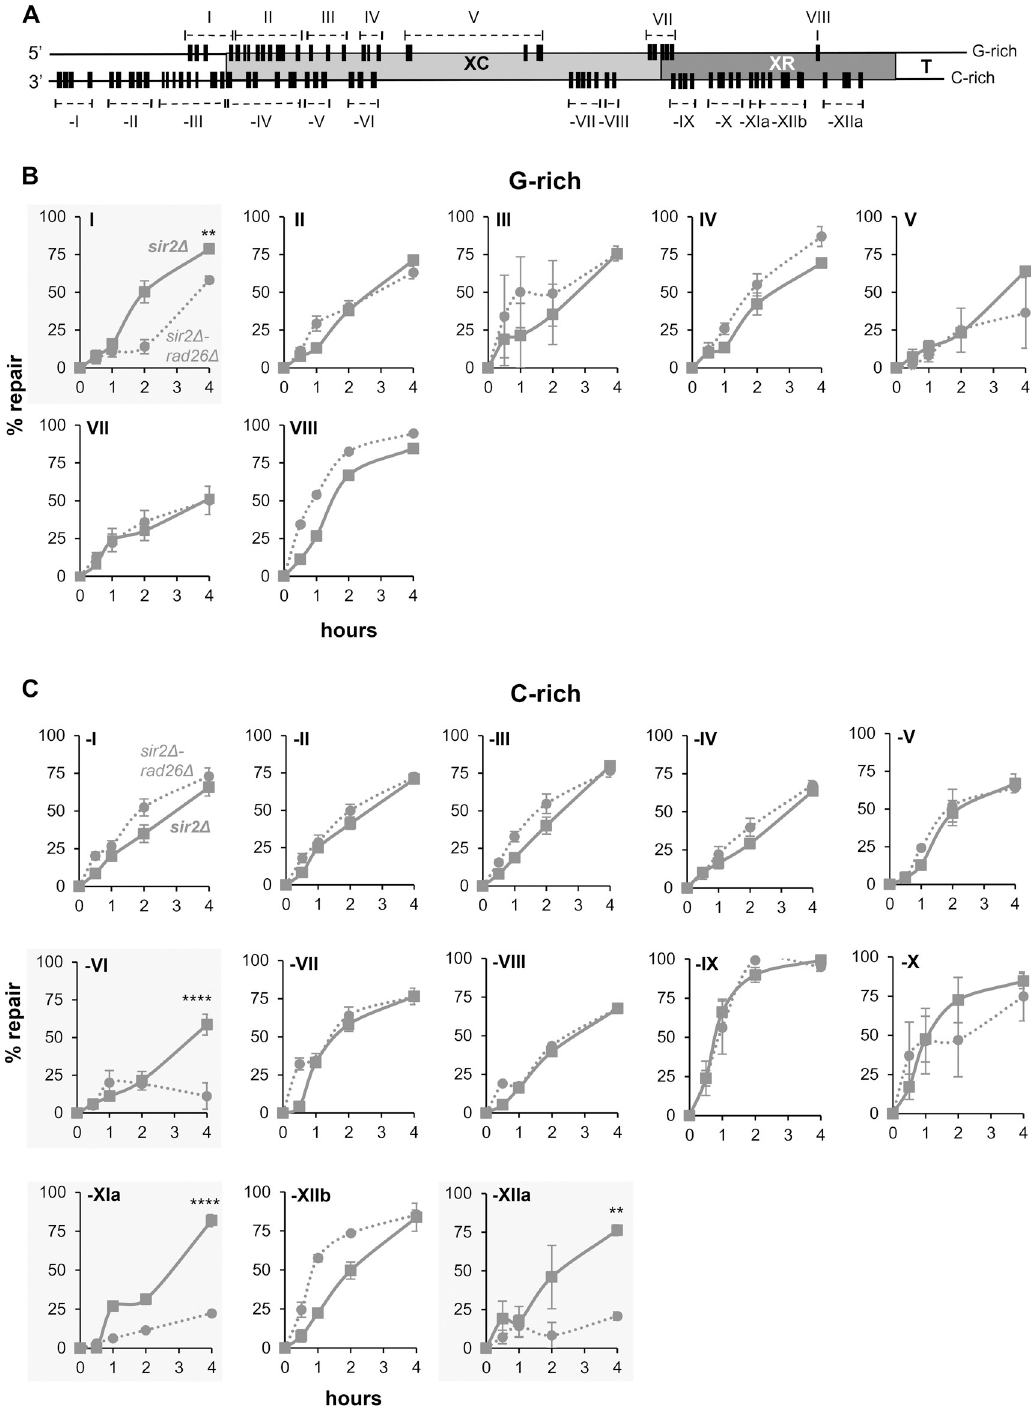
Fig 9. Repair of pyrimidine dimers in the Tel15L X-element of sir2 Δ rad26 Δ cells. (A) General map of the X-element (~730 bp) with the position of PDs (black bars), in the G- and C-rich strand, that approximatively reproduce the migration of bands in the gels of Fig 8 . (B) and (C) Repair plots (percent of repair over time) are for clusters of PDs in the G- and C-rich strand, respectively. sir2 Δ (square, continuous line) and sir2 Δ rad26 Δ (circle, dotted line); the means ± 1SE are for clusters of at least 3 PDs. P -values were calculated using a 2way ANOVA test using a Sˇı´da´k’s multiple comparisons test. P -values are indicated for the 4 h repair time point: ( �� ) p < 0.01, ( ���� ) p < 0.0001. ANOVA test cannot be applied to cluster VIII that comprises only 1 PD.